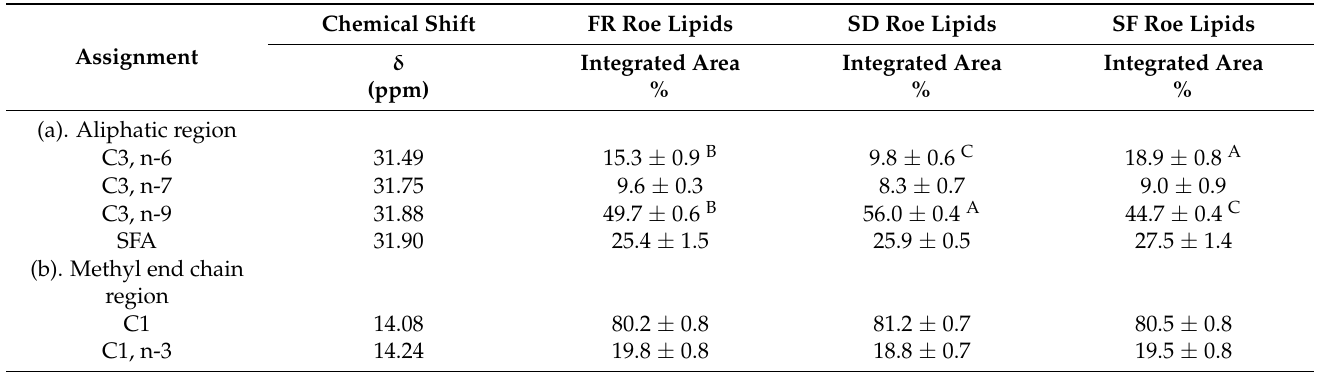
Table 4. 13 C NMR aliphatic and methyl end region of lipids extracted from fresh (FR), salted (SD), and fermented (SF) salmon